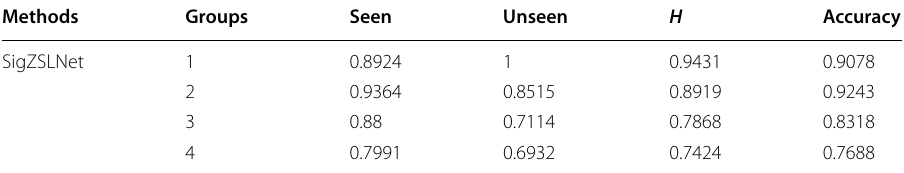
Table 5 The performance comparison among various methods Methods